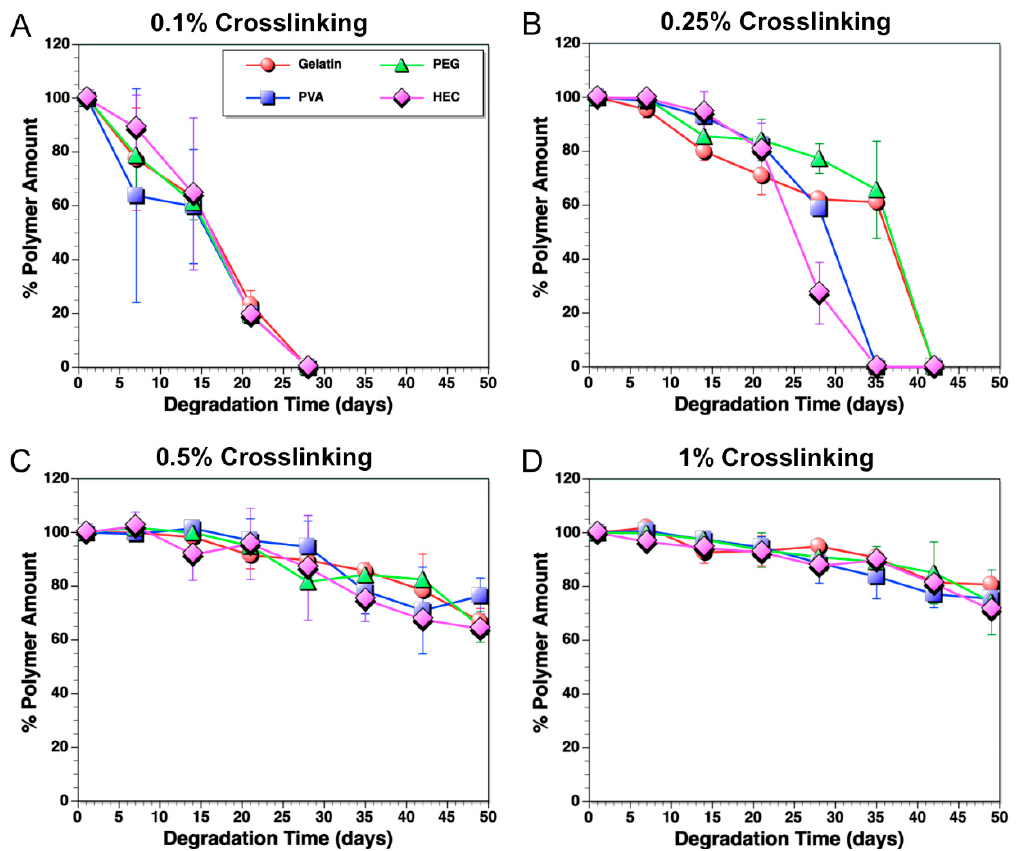
Figure 2. Degradation of polymers in PBS solution (pH 7.4) at 37 °C, which were cross-linked with different GA volume concentrations: ( A ) 0.1 vol %; ( B ) 0.25 vol %; ( C ) 0.5 vol %; and ( D ) 1 vol %.